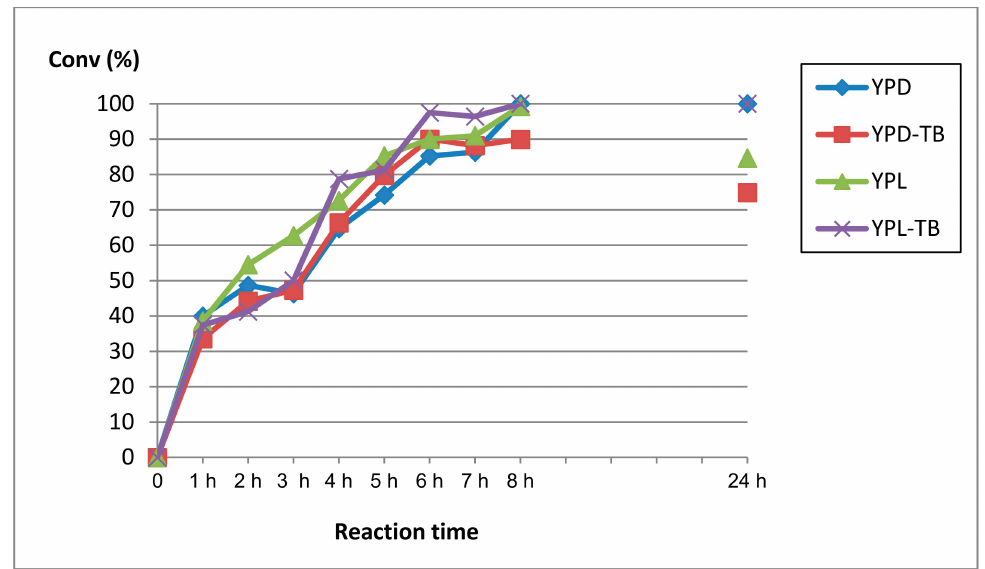
Figure 2. Yield evolution of the selective transesterification along the reaction time, operating under standard reaction conditions: 6 mL of sunflower oil, 1.75 mL of ethanol, 30 ◦ C, 25 µ L of 10 N solution of NaOH, higher stirring than 300 rpm, along 24 h as reaction time. As a biocatalyst, 0.5 g of enzymatic extract of the standard CA strain from CECT, obtained from several extracts of YPD and YPL, with and without tributyrin, after 72 h of growth time, are